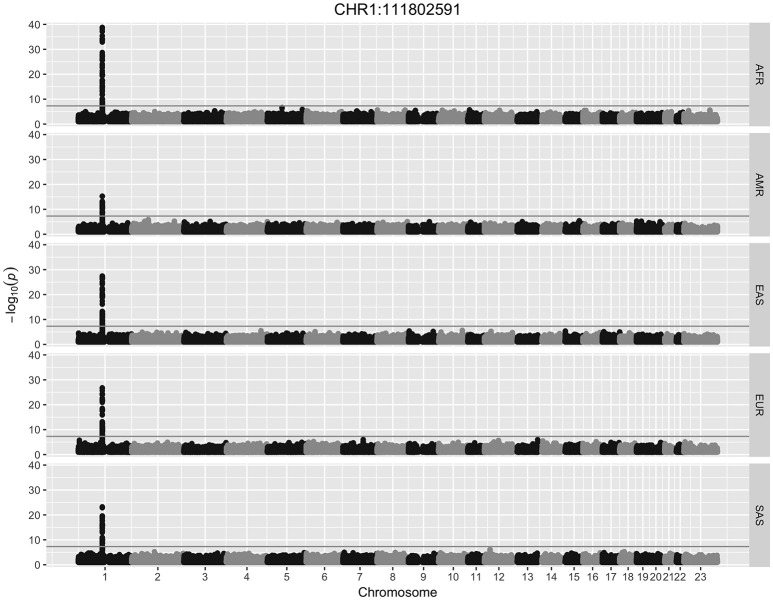
Manhattan plot. Results from a genome-wide association study for a polymorphic HERV-K insertion discovered with HERVnGoSeq at chr1:111802591. The gray horizontal line represents the threshold for genome-wide significance of 5 × 10−8. Logistic regression was performed separately within each of the five super populations in the 1,000 Genomes. AFR, African; AMR, Ad Mixed American; EAS, East Asian; EUR, European; SAS, South Asian.